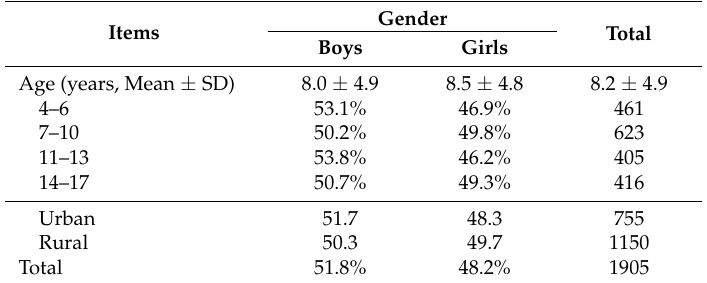
Table 1. Characteristics of the study subjects. SD, standard deviation.